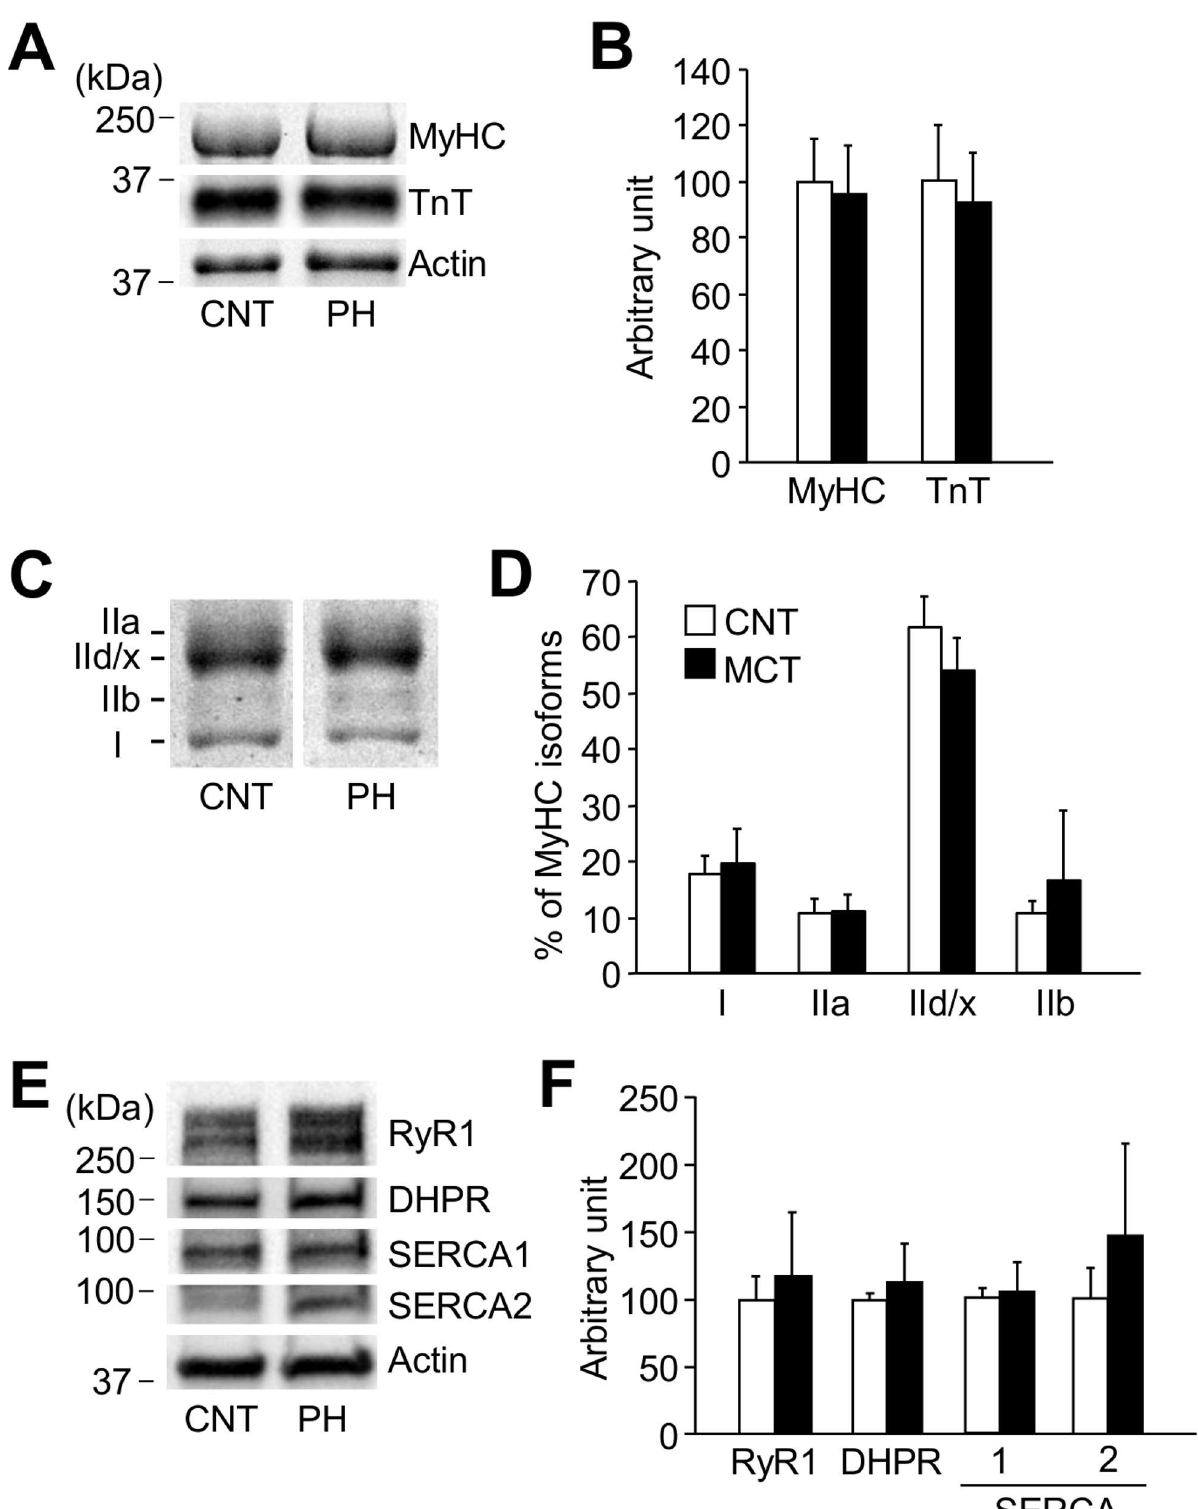
Fig 2. Neither contractile proteins nor excitation-contraction coupling proteins are altered in PH diaphragm muscles. A : Stain free images of myosin heavy chain (MyHC) and western blots of troponin(Tn) T. B : the expressionlevels of MyHC or TnT normalizedto actin